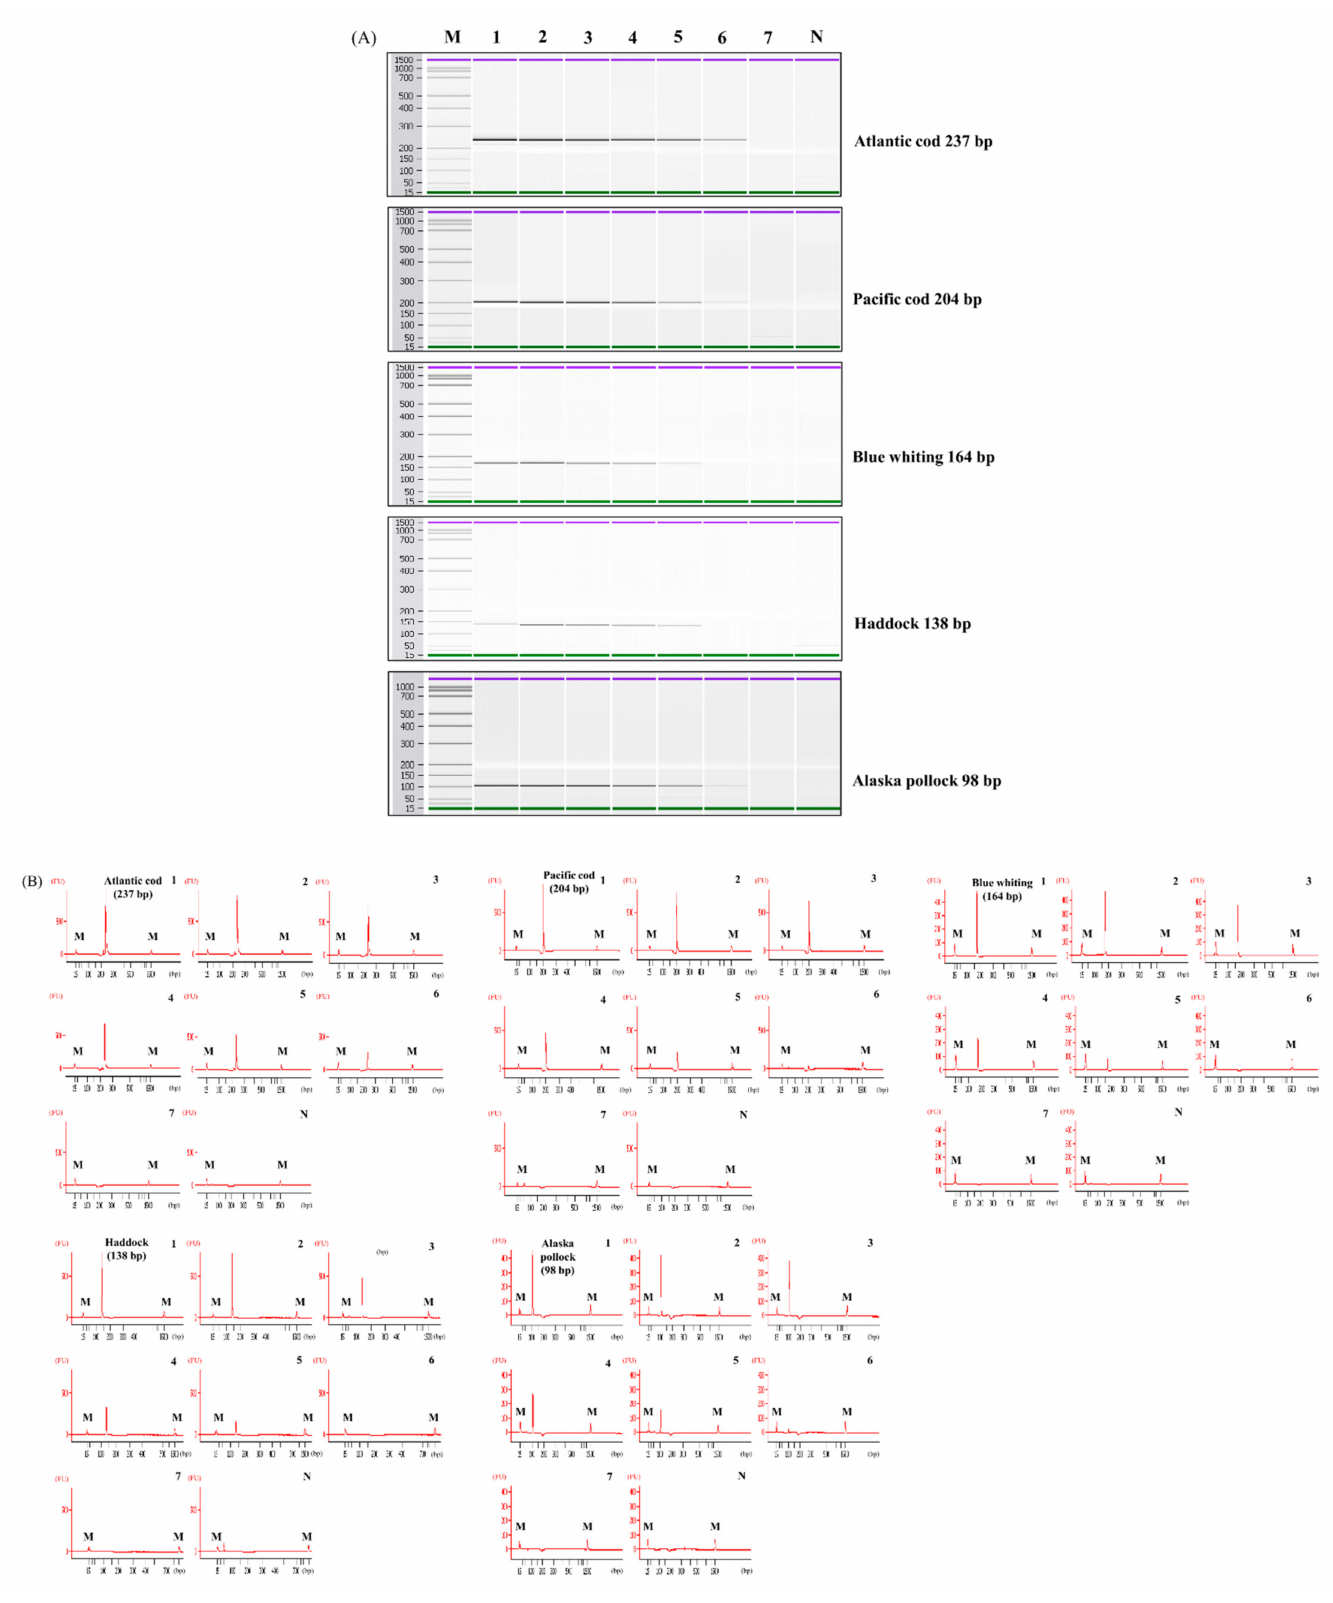
Figure 2. Sensitivity of the simplex PCR assay. ( A ) Gel, and Lane M: 100 bp DNA ladder, lanes 1–7: 10 ng to 0.01 pg of DNA from target species, and lane N: non-template. ( B ) Electropherogram, M: alignment marker, lanes 1–7: 10 ng to 0.01 pg of DNA from target species, and lane N: